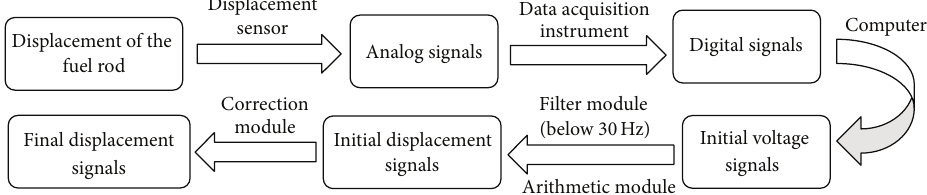
Figure 10: Schematic diagram of data acquisition